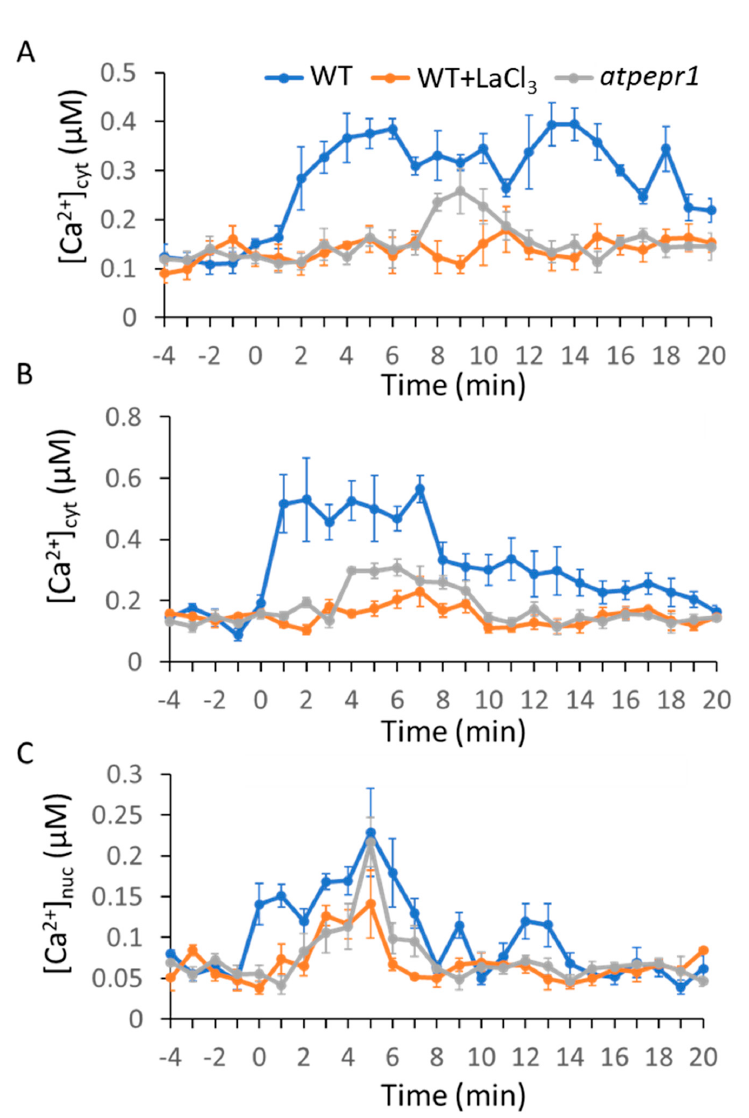
Figure 3. AtPep1-induced cytoplasmic or nuclear Ca 2 + transients in aequorin-expressing Arabidopsis plants or transient AEQ-expressing mesophyll leaf transfected protoplasts. Here, 1 µM AtPep1 was added at time 0 to wild-type (WT; blue lines), WT with LaCl 3 (orange lines), or atpepr1 mutant (grey lines) plants as noted in ( A – C ). ( A ) The leaf samples. ( B ) Leaf mesophyll protoplasts transfected with AEQ. ( C ) Leaf mesophyll protoplasts transfected with AEQ-NLS. The curves shown are averages generated from four biological replicates; leaves for each replicate were taken from different plants. The bioluminescence was measured at 1 min time intervals, and SE was calculated for each mean; SE values are portrayed as error bars.